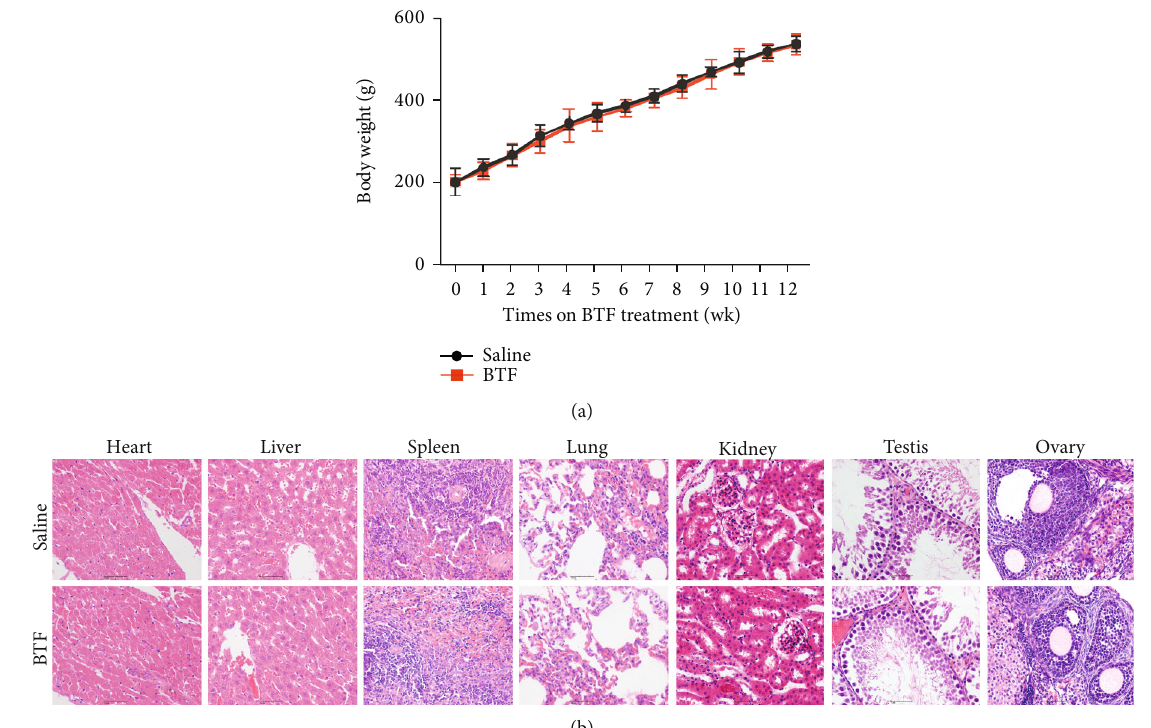
Figure 5: Oral administration of BTF presents no toxicity for rats. (a) The monitoring curve of body weight demonstrated no signi fi cant di ff erence between saline and BTF treatment groups. (b) Representative images of H&E staining of tissue sections from multiple organs. SD rats (200 – 220g) were treated with a daily dose of 54g/kg of BTF for 12 consecutive weeks ( n = 6 ). Continuous weekly weight records were kept, and the heart, liver, spleen, lung, kidney, testis, and ovary were collected for pathological analysis at the end of the